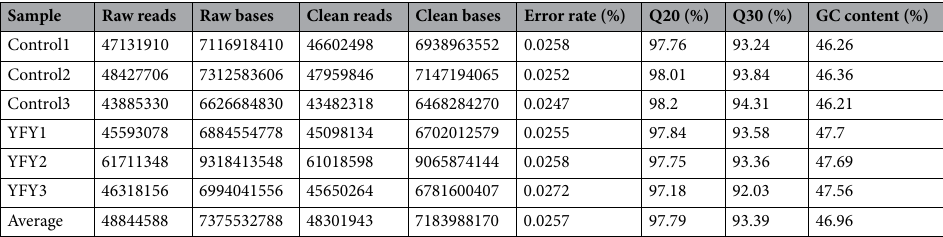
Table 1. Sequencing statistics for control and